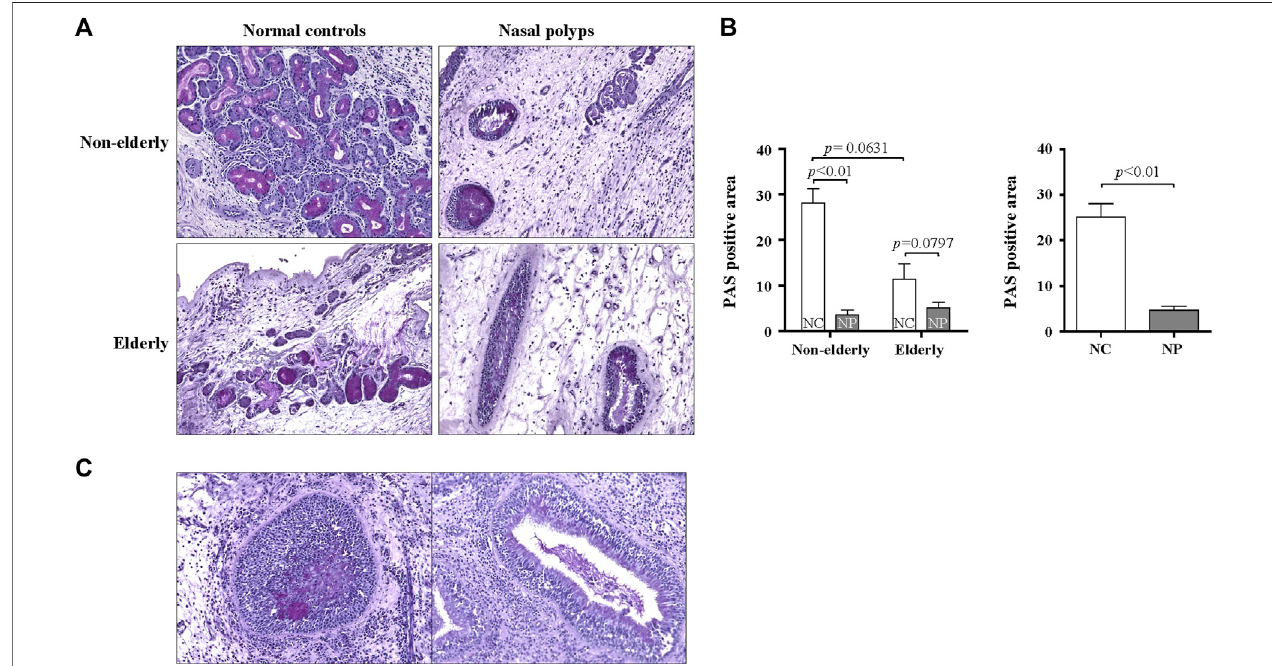
FIGURE2| HistopathologicchangesofthesubmucosalglandinthesinonasaltissuesfromsubjectswithNPandnormalcontrols. (A) RepresentativePASstaining for histopathologic changes on sinonasal tissue sections of NP and normal controls. Original magni fi cation ×200. (B) Quanti fi cation of the PAS positive areas was performed using ImageJ. Data are expressed as the means ± SE (non-elderly NC versus elderly NC, n = 19, p = 0.0631; NC versus NP, n = 30, p < 0.01). NC, normal control; NP, nasal polyp. (C) PAS stained abnormal gland morphology. Original magni fi cation